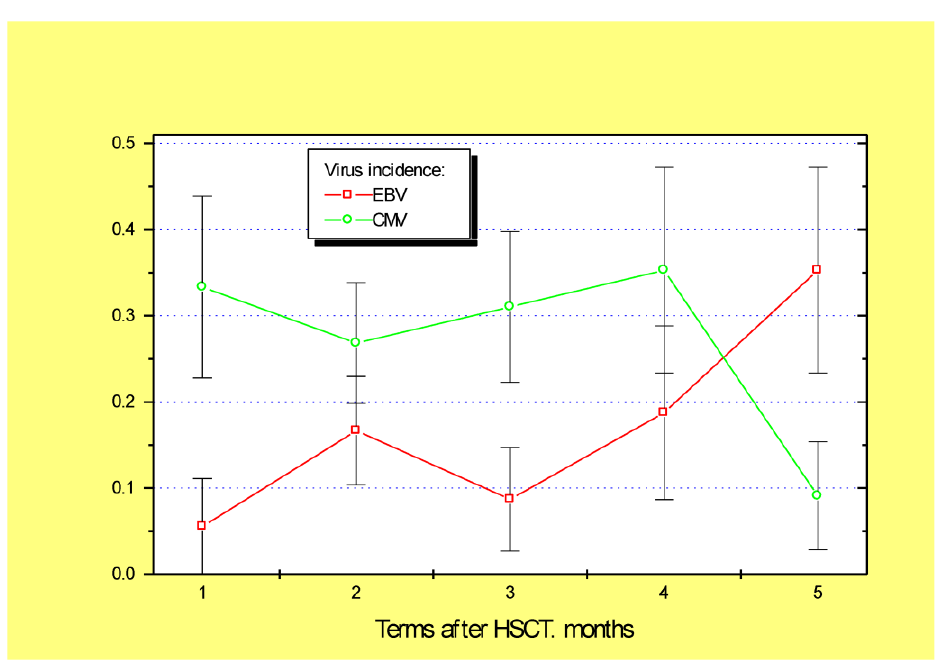
Figure 1. General incidence of HSV (red squares) and HHV-6 (green circles) in the intestinal biop- sies from the first month (D + 1 to D + 30) up to 5 – 6 months after allogeneic HSCT. Abscissa, time period following HSCT, in months; ordinate, incidence of positive PCR viral tests (M ± m).